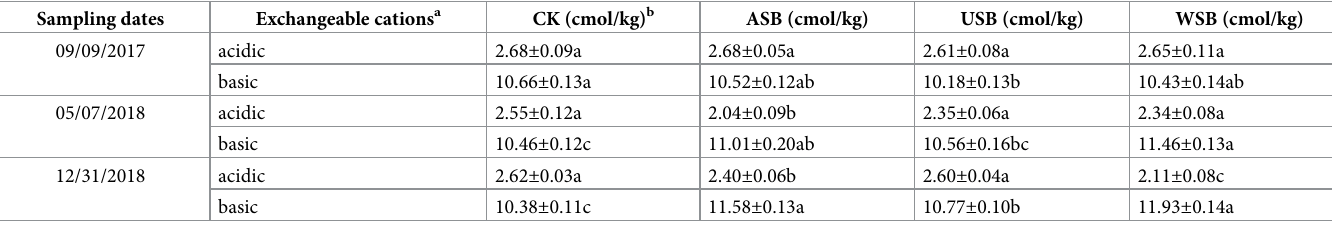
Table 1. Changes of soil exchangeable acidity and exchangeable bases in soybean planting and covering treatments. Sampling